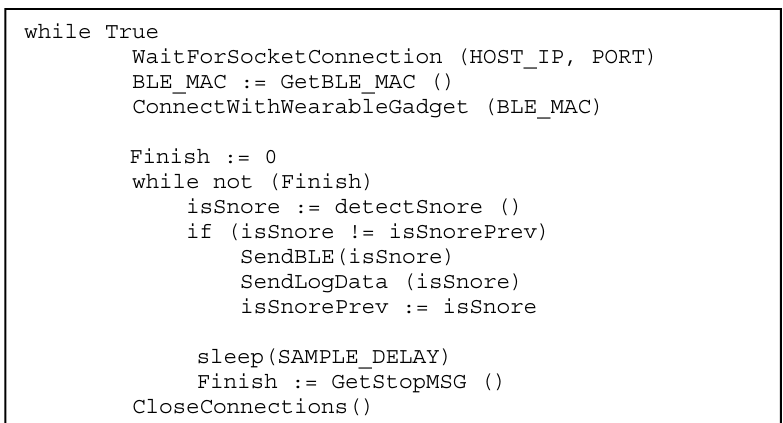
Figure 5. Pseudocode of the application layer firmware of the listener module.